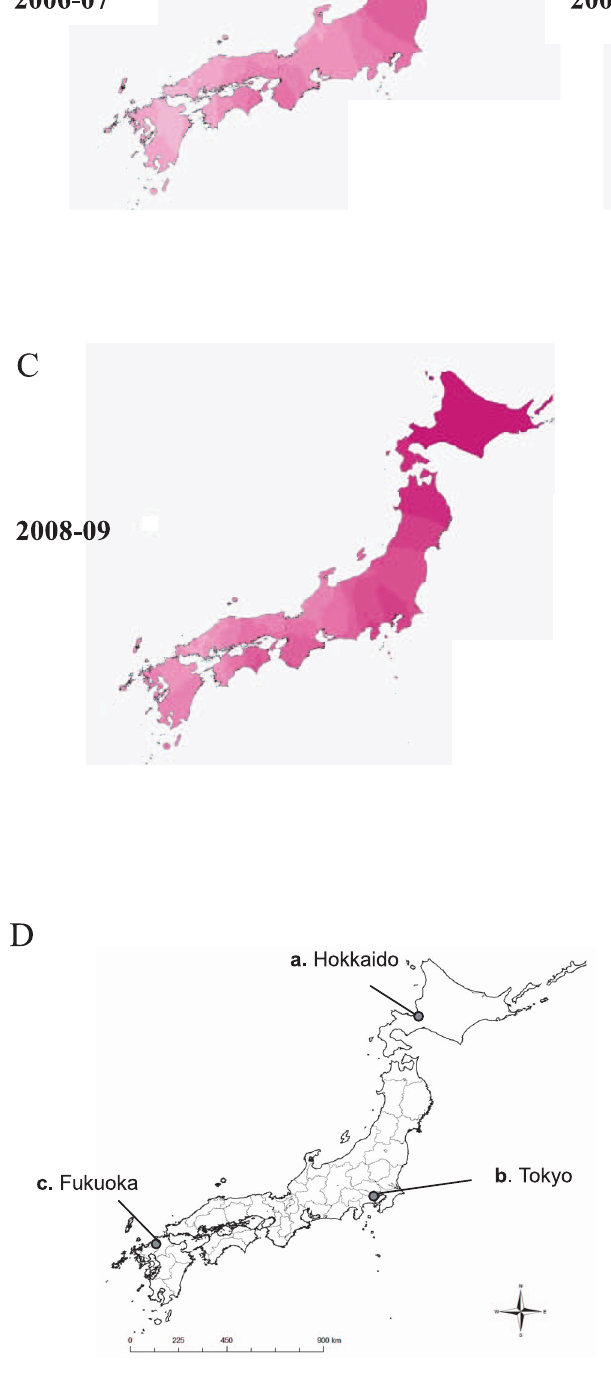
Figure 1. Weekly increase of cases. Spatial distribution of the weekly increase of sentinel cases is depicted by the kriging method (ordinary kriging) at classification colours of 1-week intervals. The first week was defined when more than 4.0 cases per sentinel site was observed in any of the